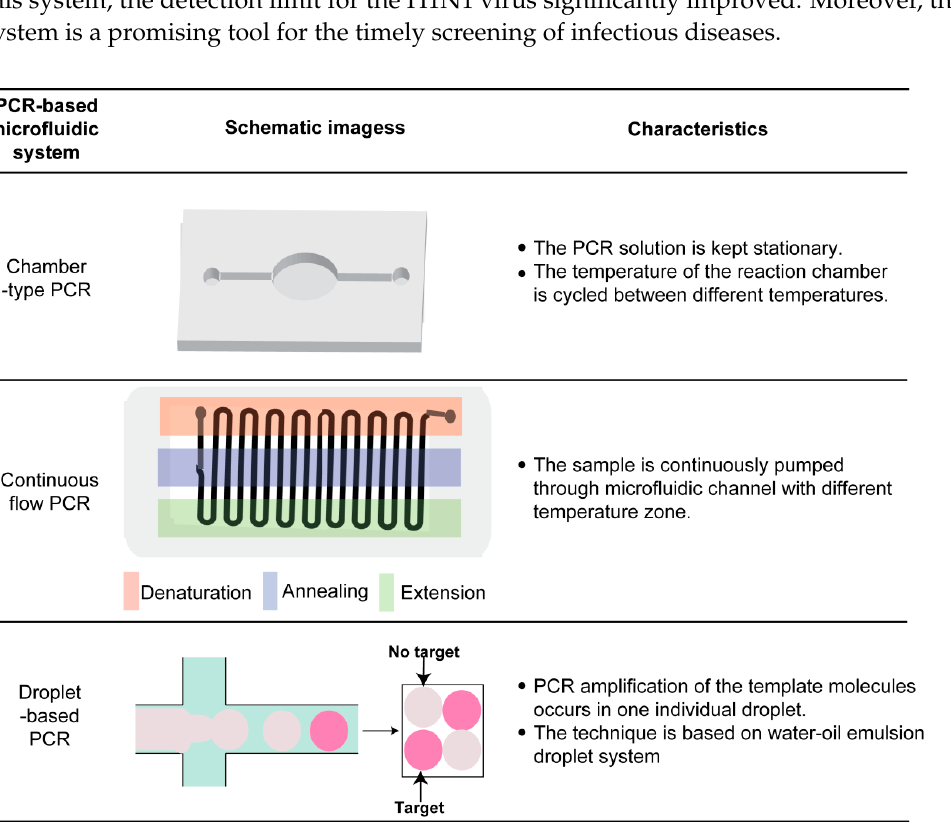
Figure 2. PCR-based microfluidic